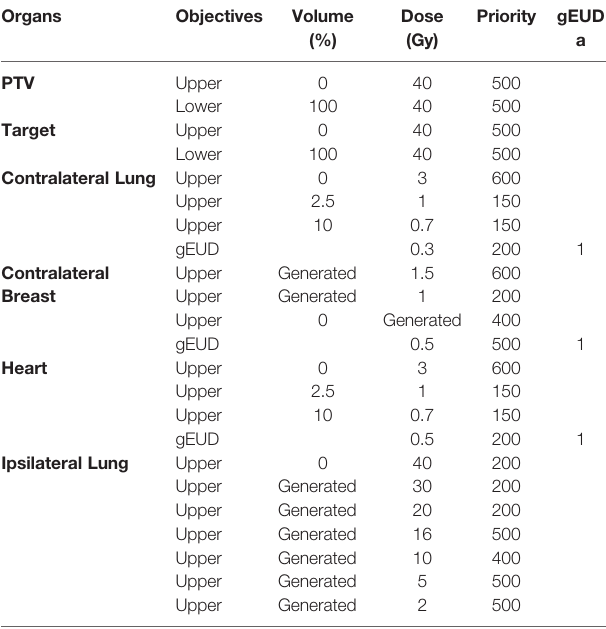
The parameters obtained by the RapidPlan prediction automatically replace the “ Generated ” placeholder.